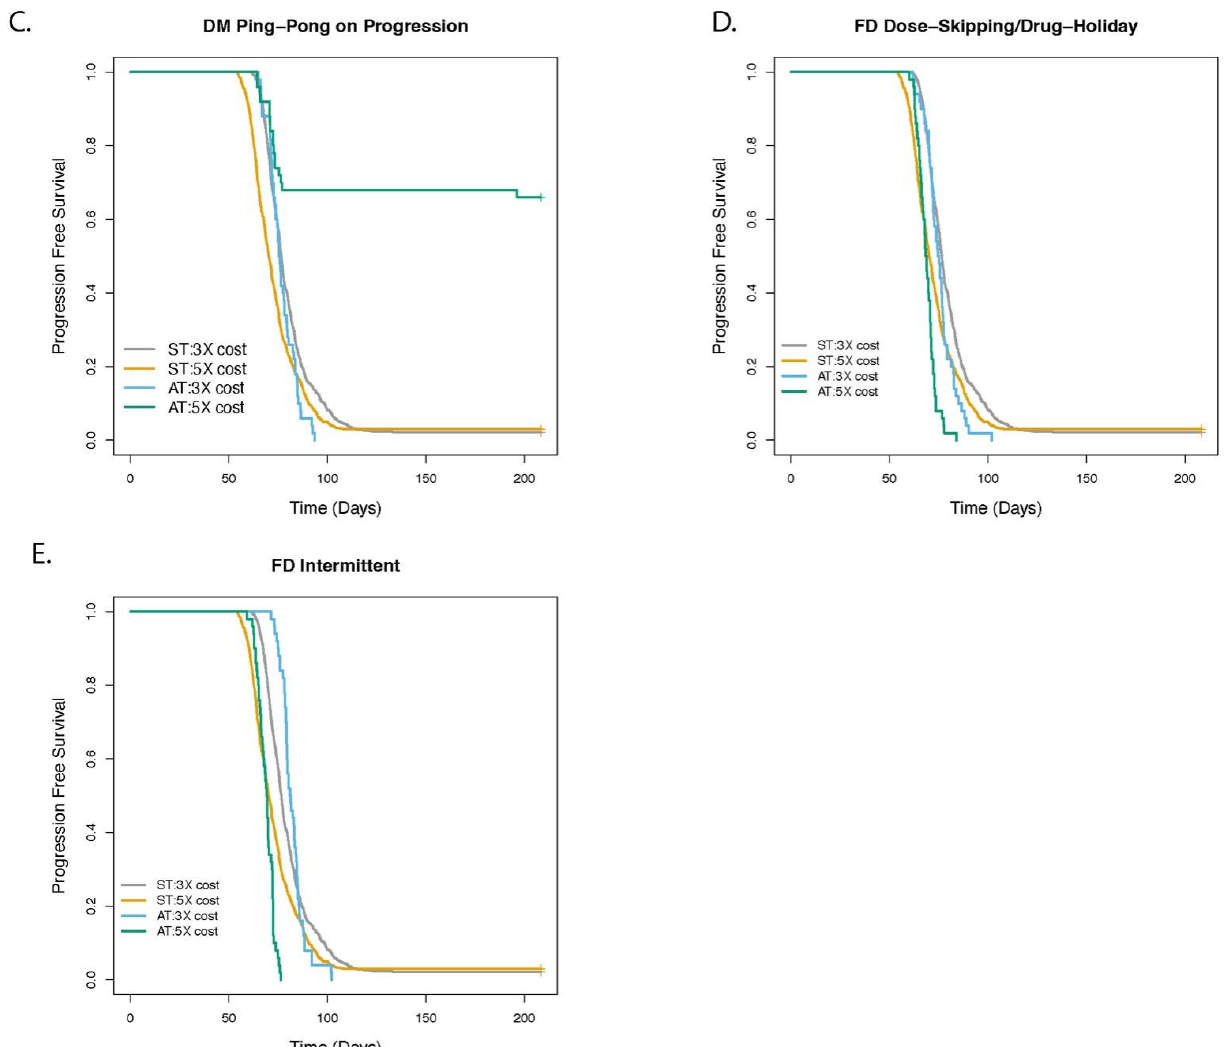
Figure 5. Role of fitness cost in determining the outcome of adaptive therapy with 2 drugs. The panels show the comparison of adaptive therapy (AT) versus standard treatment (ST) as fitness cost for resistance is varied for ( A ) DM Cocktail Tandem, ( B ) DM Ping-Pong Alternate Every Cycle, ( C ) DM Ping-Pong on Progression, ( D ) FD Dose-Skipping/Drug-Holiday, ( E ) FD Intermittent. 5 × fitness cost is the default, with the division rate of doubly sensitive cells being 0.06/h, doubly resistant cells being 0.02/h, and that of the singly resistant cells being 0.04/h, while the death rate of all cell types was 0.01/h, translating to a net growth rate of the doubly sensitive cells at 5 times (5 × ) that of the doubly resistant cells. We compared this to a 3 × fitness cost, with the division rate of doubly sensitive cells being 0.04/h, doubly resistant cells being 0.02/h, and singly resistant cells being 0.03/h, while the 3 times (3 × ) that of the doubly resistant